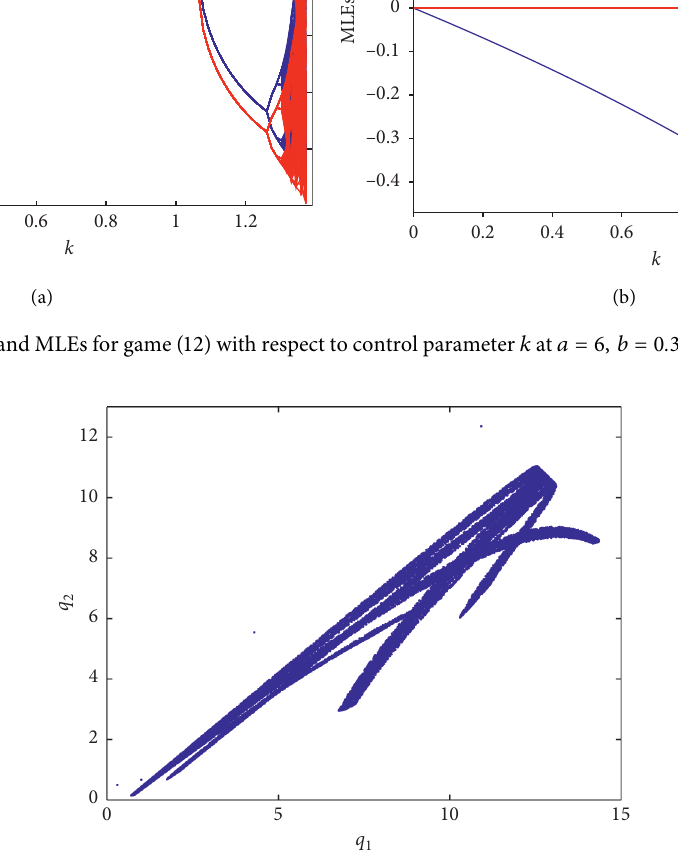
Figure 4: Phase portraits of the chaotic attractor of game (12) are shown using parameters values a � 6 , b � 0 . 3 , c and k � 1.4.